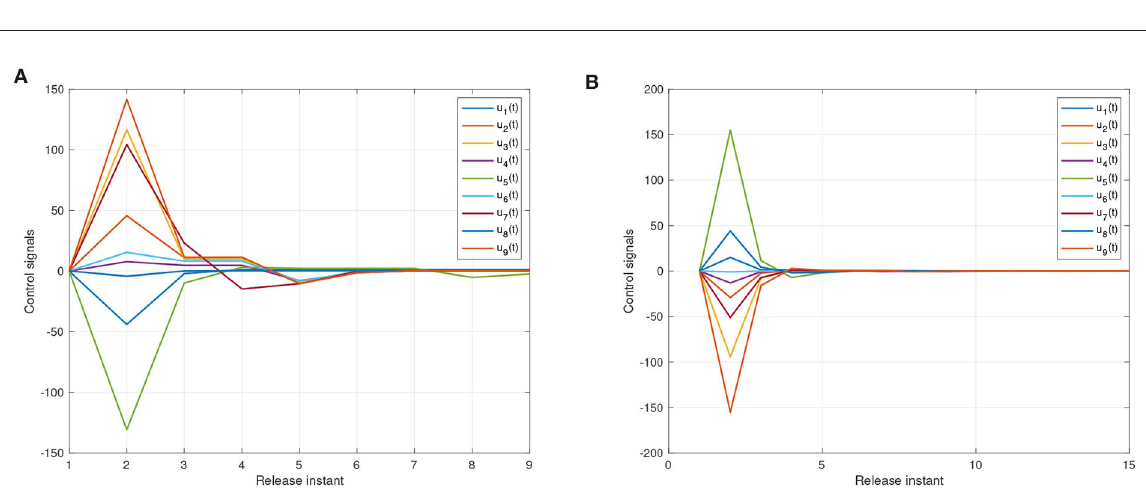
FIGURE8 The states of event-triggered controller (11). (A) Instants for synchronization ε ( t )